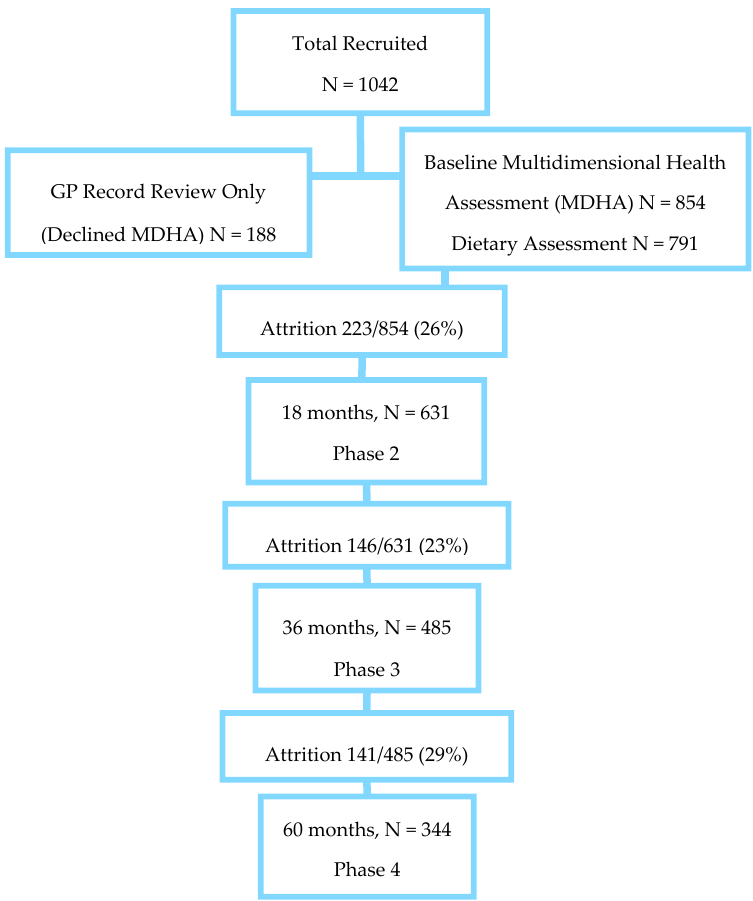
Figure 1. Flow diagram of participant recruitment and sample size at each stage.